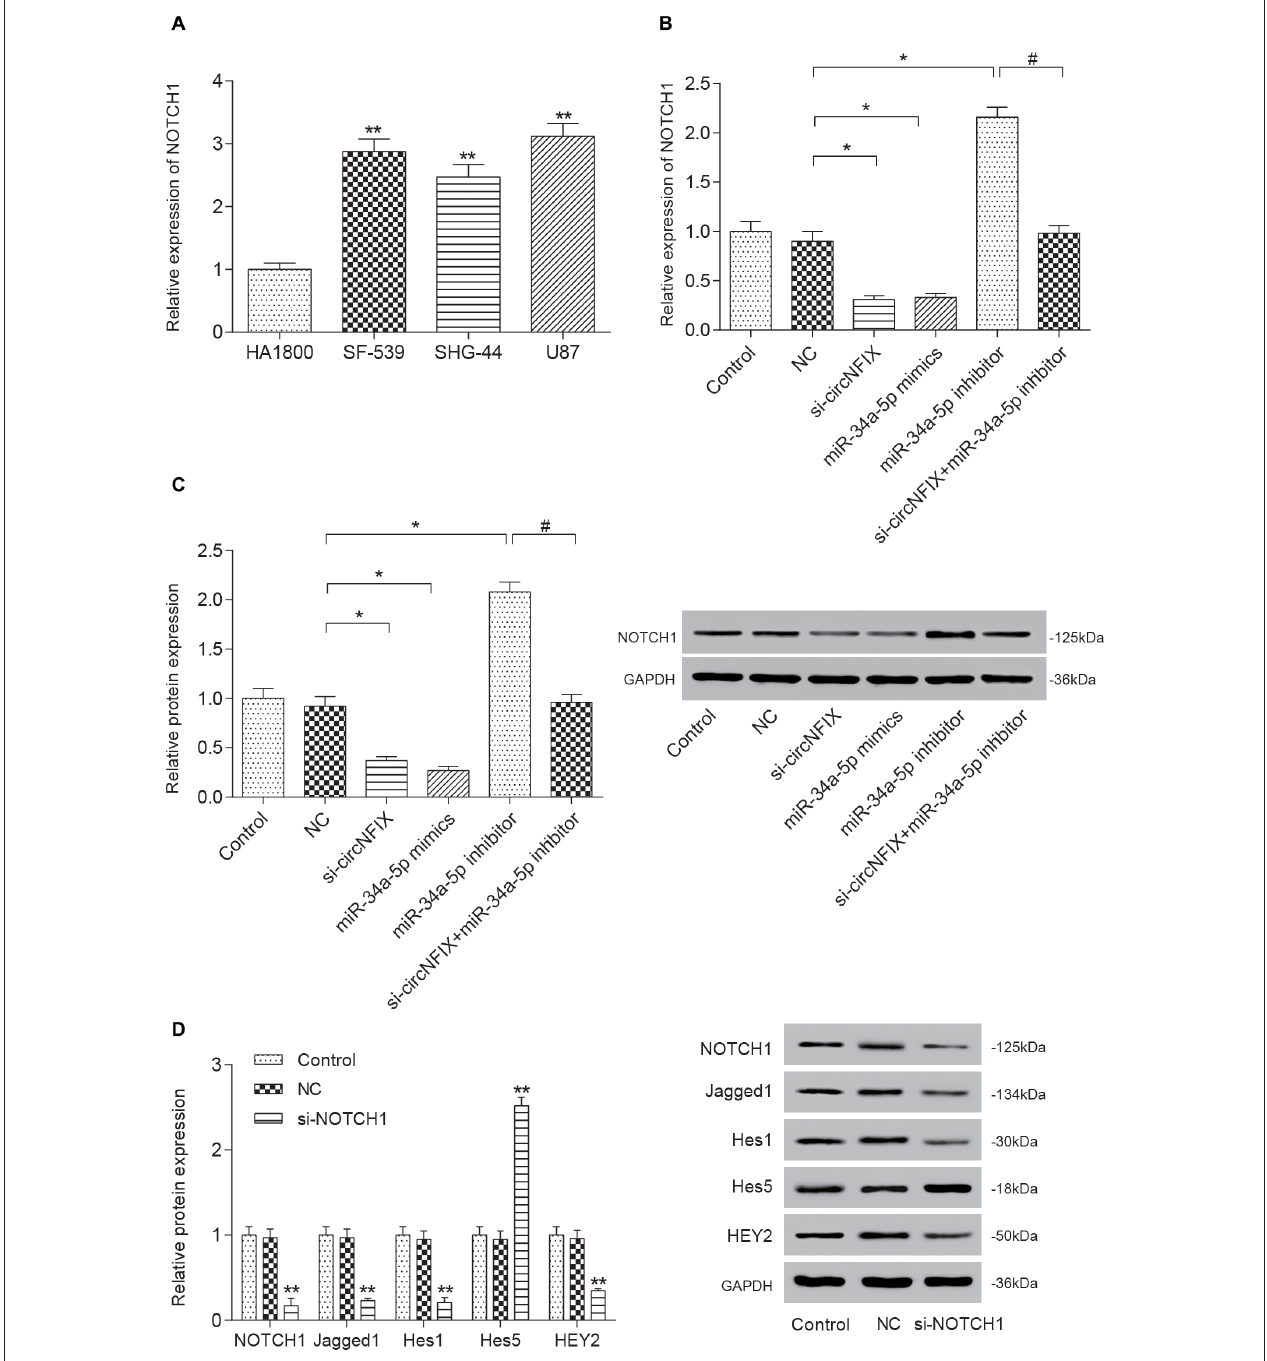
FIGURE 5 | Si-circNFIX and miR-34a-5p mimics inhibited NOTCH1 expression and protein expression downstream of the signaling pathway. (A) The qRT-PCR assay analyzed the expression levels of NOTCH1 . (B) The qRT-PCR assay analyzed the expression levels of NOTCH1 after the U87 cells were transfected with si-circNFIX, miR-34a-5p mimics and the miR-34a-5p inhibitor. (C) Western blotting analyzed the protein expression of NOTCH1 after the transfection. (D) Western blotting analyzed the protein expression in the signaling pathway. ∗ P < 0.05, ∗∗ P < 0.01 compared with the NC group, # P < 0.05 compared with the si-circNFIX